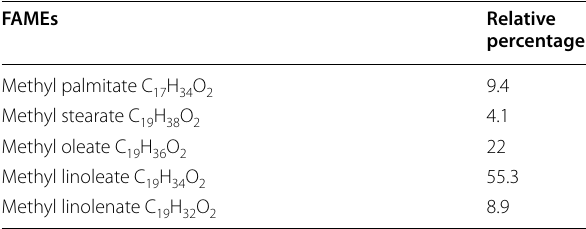
Table 1 Fatty acid methyl ester composition of soybean